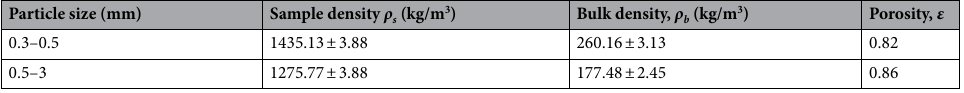
Table 1. Sample density, bulk density and porosity for P. niruri . ± Standard deviation for three